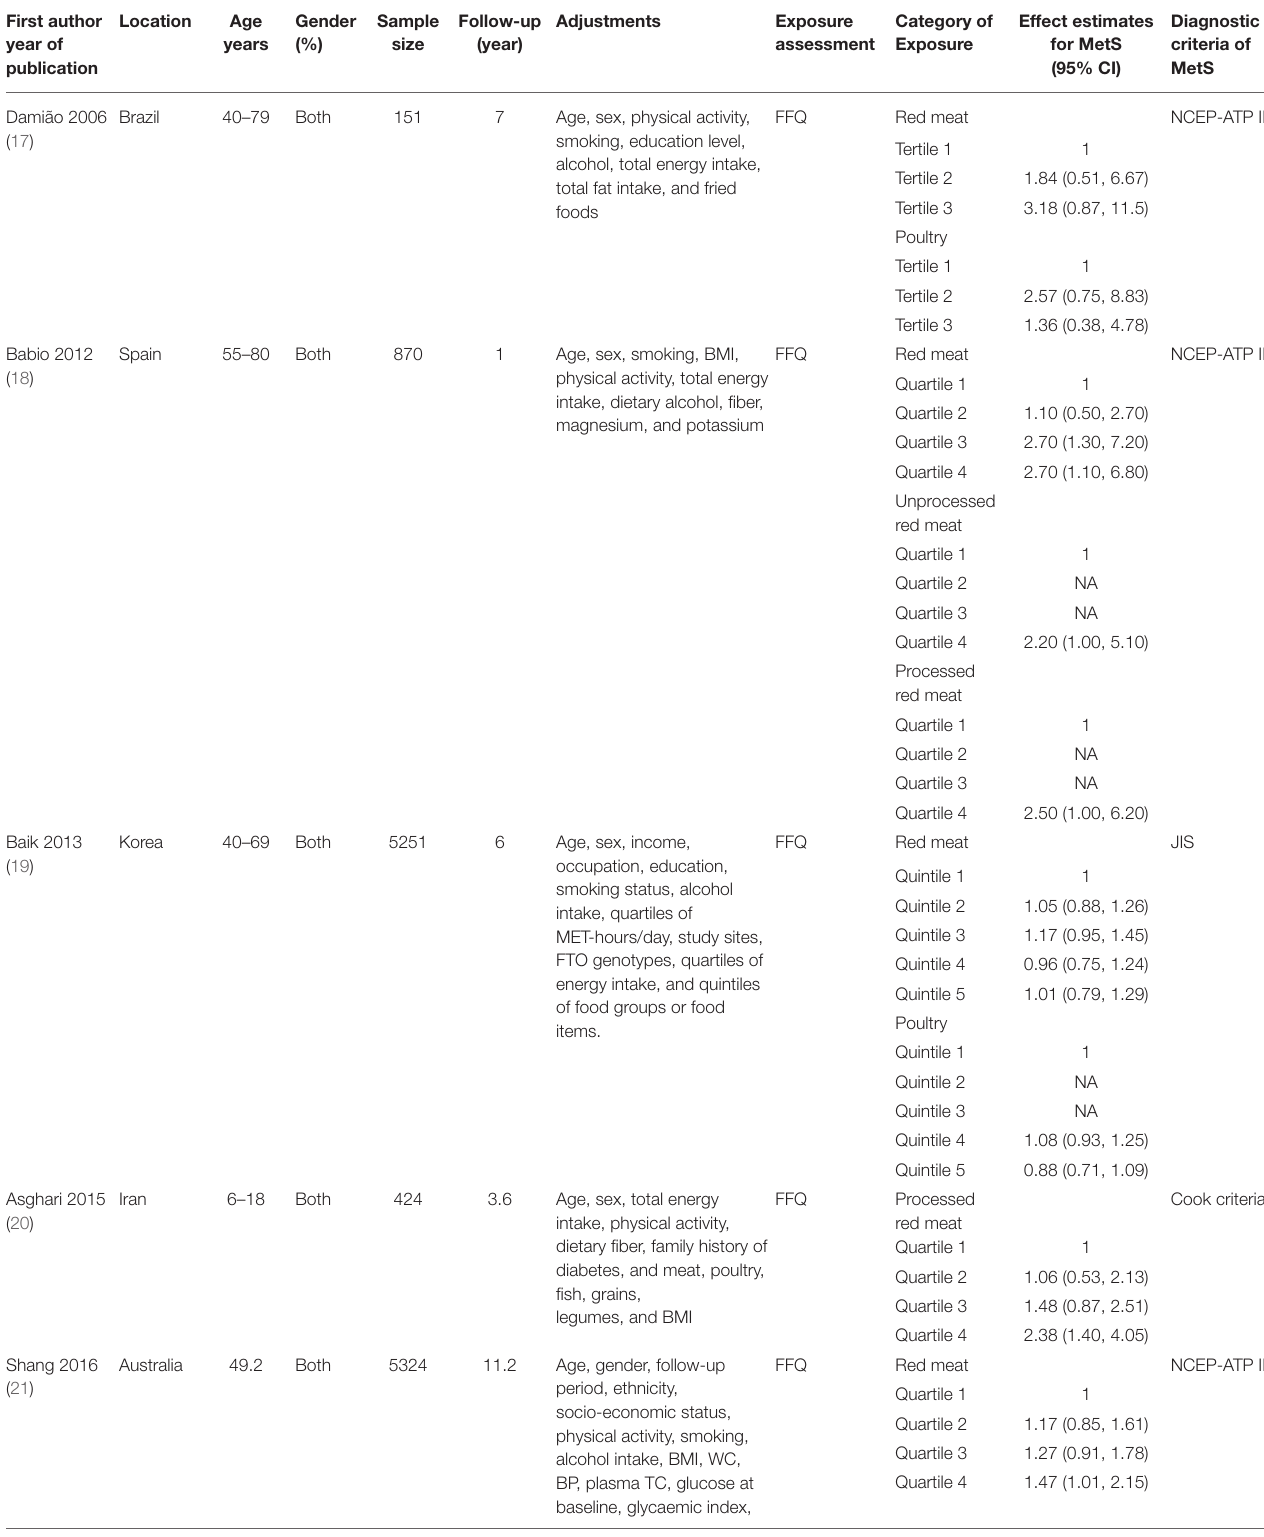
TABLE 1 | Characteristics of prospective cohort studies included in this